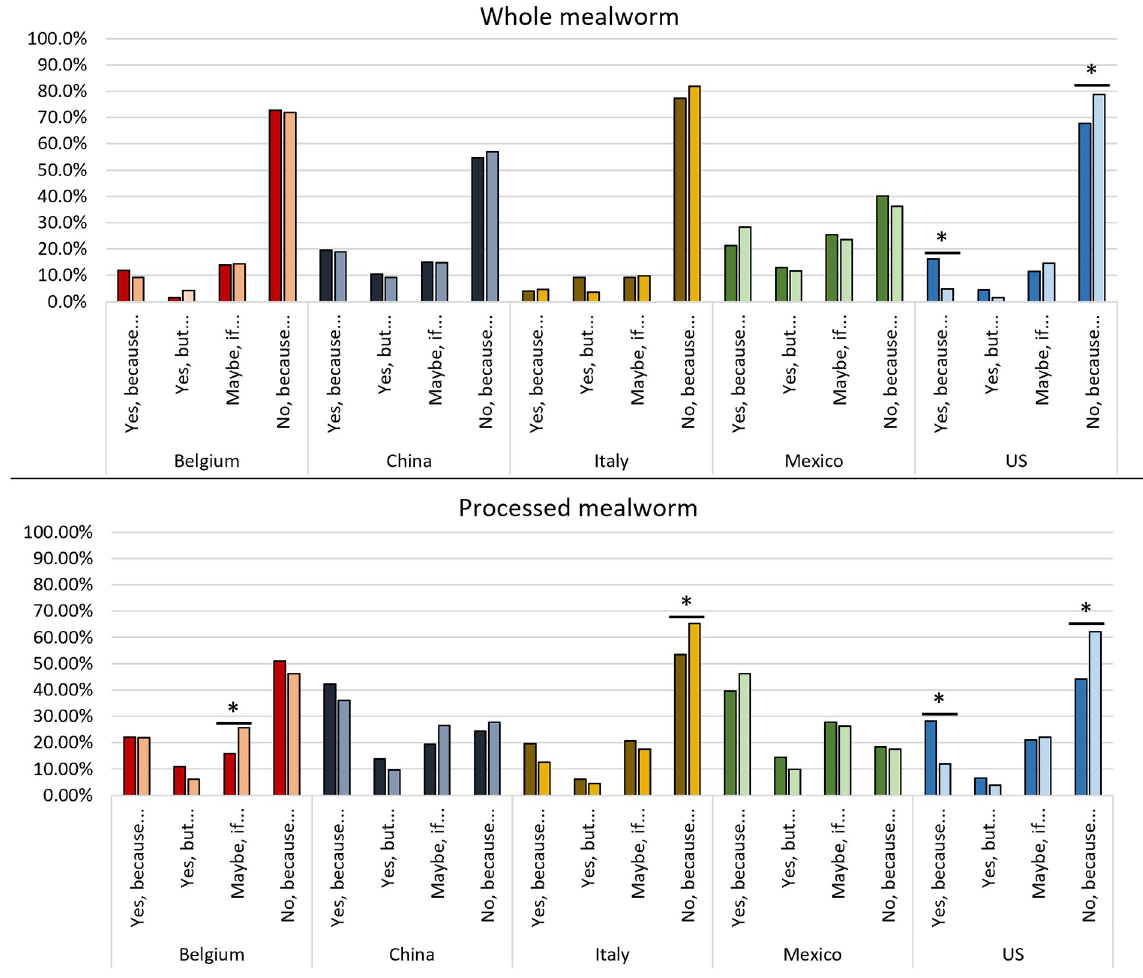
Fig 4. Effects of age on the acceptance level towards the inclusion of whole and processed mealworms in the diet in different countries. 41 years or younger: dark columns; 42 years or older: light columns. � Significant difference assessed by Chi 2 test of homogeneity with post hoc test (z-test of two proportions) with Bonferroni’s correction ( P < 0.0125).